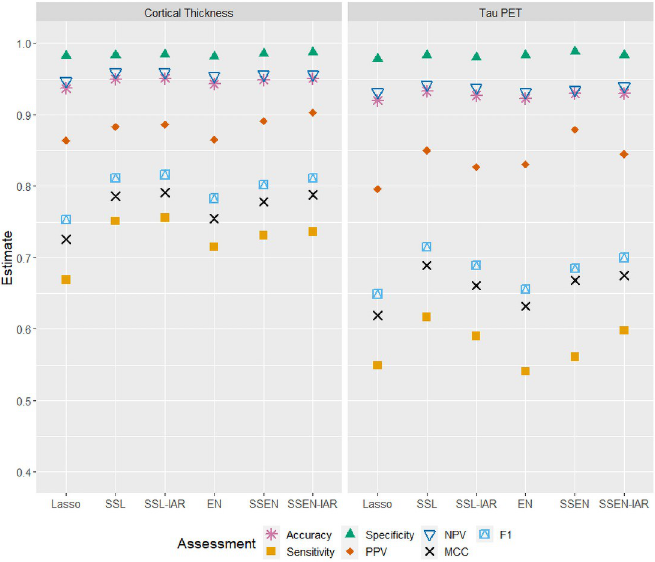
Fig 3. ADNI data classification performance when using cortical thickness measures (LEFT) or tau PET SURV (RIGHT) as predictors/features.